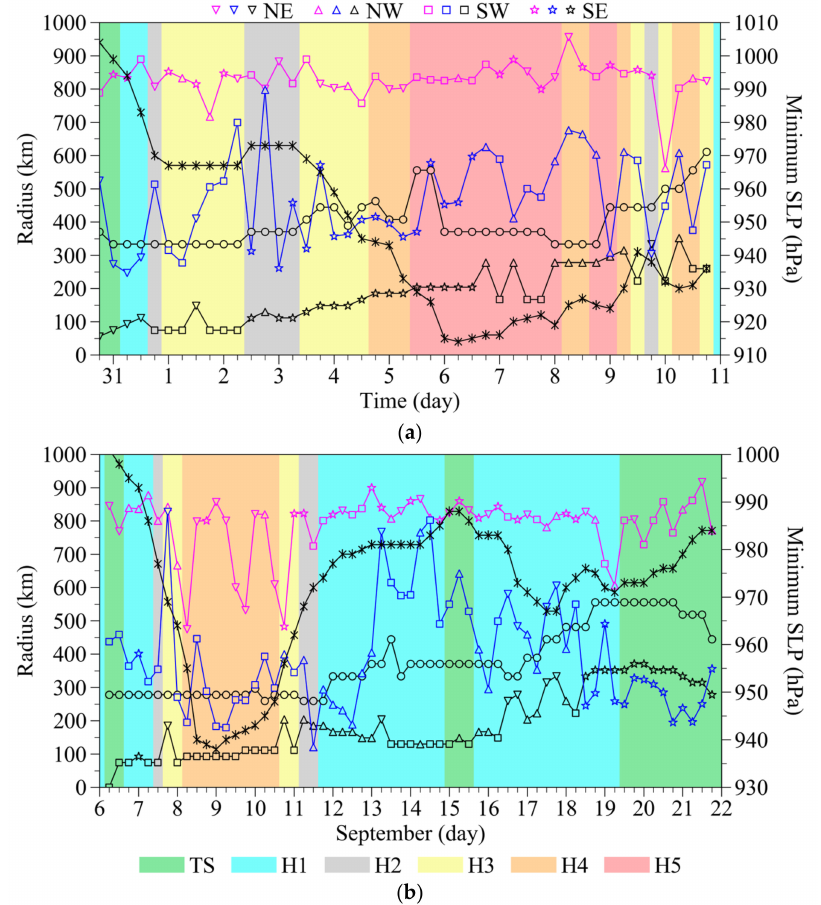
Figure 9. Temporal evolutions of R OR (magenta markers indicating quadrants) and R IR (blue markers indicating quadrants) along northeast (NE), northwest (NW), southwest (SW), and southeast (SE) directions, radius of the outermost closed isobar (black open circle), the radius of the 34 kt wind (black markers indicating quadrants) in the same quadrants as R IR , and minimum SLP (black star markers) of ( a ) Hurricane Irma from 1800 UTC August 30 to 1800 UTC September 10, 2017 and ( b ) Jose from 0600 UTC September 6 to 1800 UTC September 21, 2017. Intensity categories are shown in color